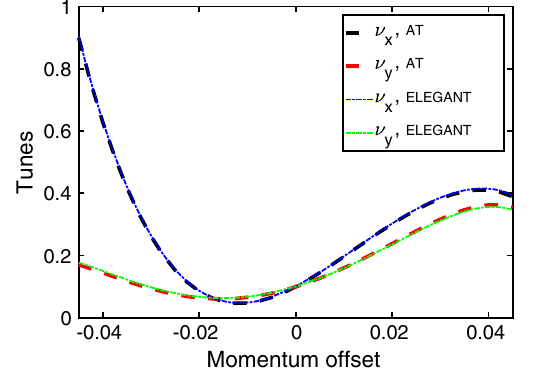
FIG. 10. Comparison of betatron tunes as a function of momentum deviation calculated by AT and ELEGANT .